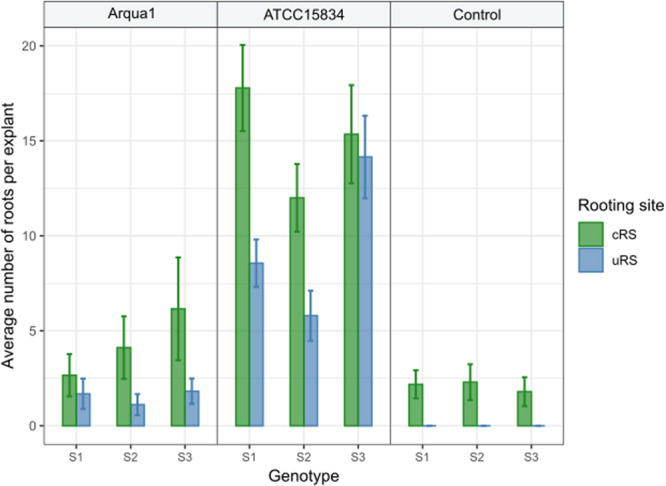
Average number of roots formed per explant rooting site of Arqua1, ATCC15834 and control co-cultivated leaf disk explants (cRS, conventional rooting site; uRS, unconventional rooting site). Error bars indicate the 95% confidence interval for the mean.